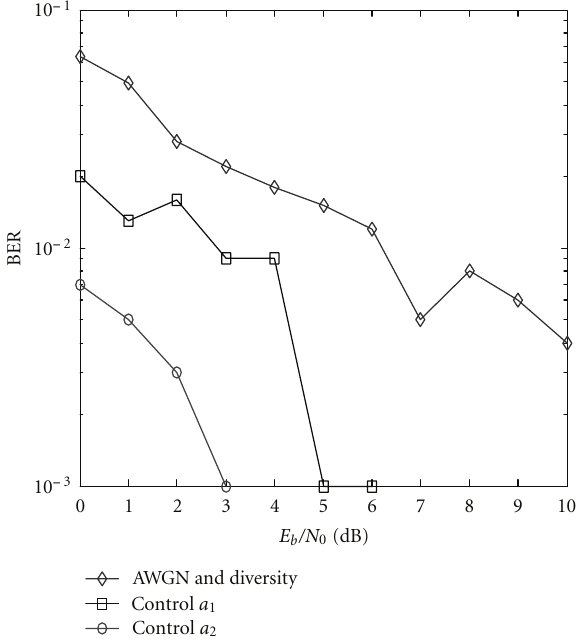
Figure 13: BER performance in antenna diversity.